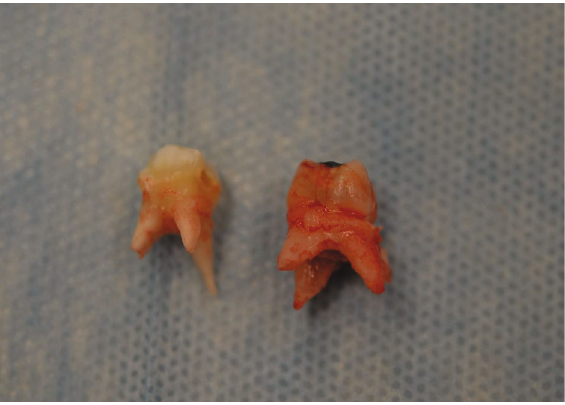
Figure 3: Teeth 54 and 55 removed.